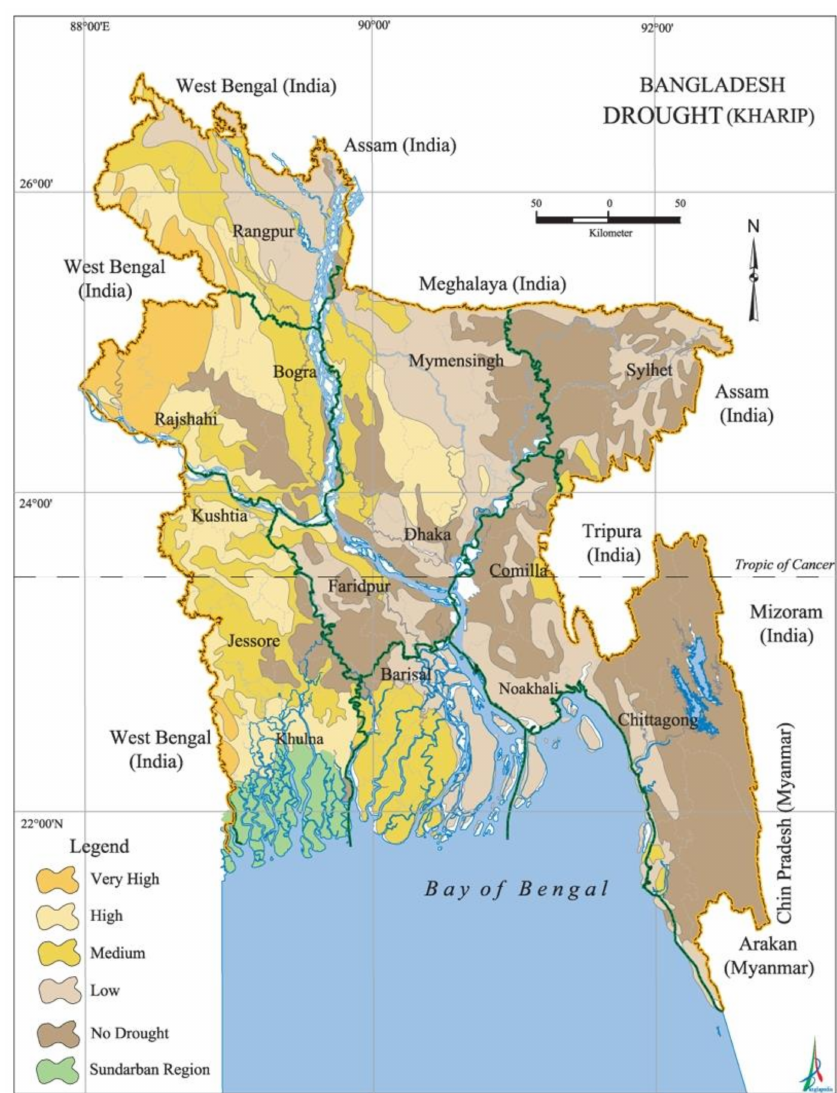
Figure 1. Map of Bangladesh showing drought-prone areas